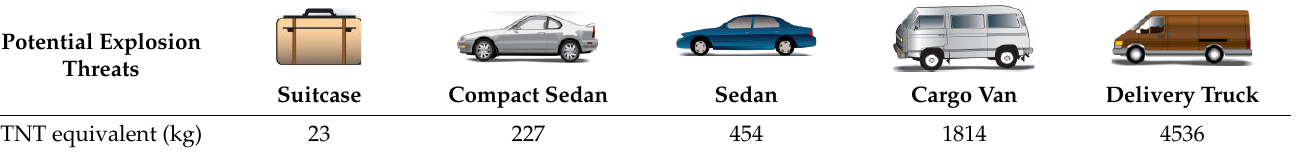
Figure 10. FE model of the prototype of tunnel entrance (unit: mm). Table 11. Mass of the potential explosion threats.